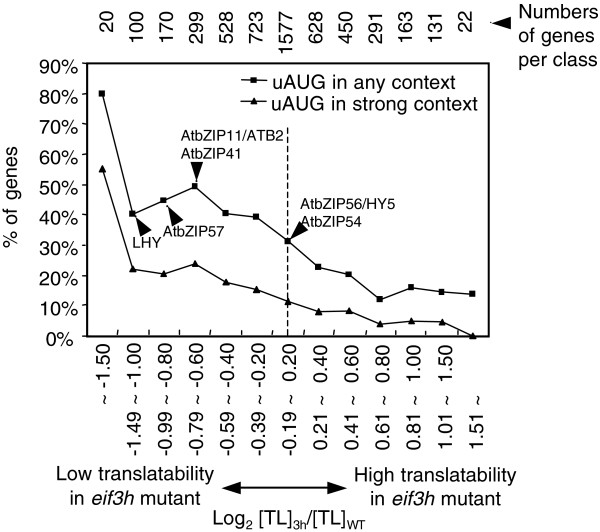
eIF3h is responsible for enhancing the translation state of mRNAs harboring upstream AUGs. mRNAs were classified into bins according to the difference in translation state between eif3h mutant and wild type (log2 [TL]3h/[TL]WT). The proportion of genes containing uAUGs was determined for each bin. 'Strong context' refers to uAUGs in the sequence context AnnAUGn or GnnAUGG, which are close matches to the optimal Kozak consensus for translation initiation.